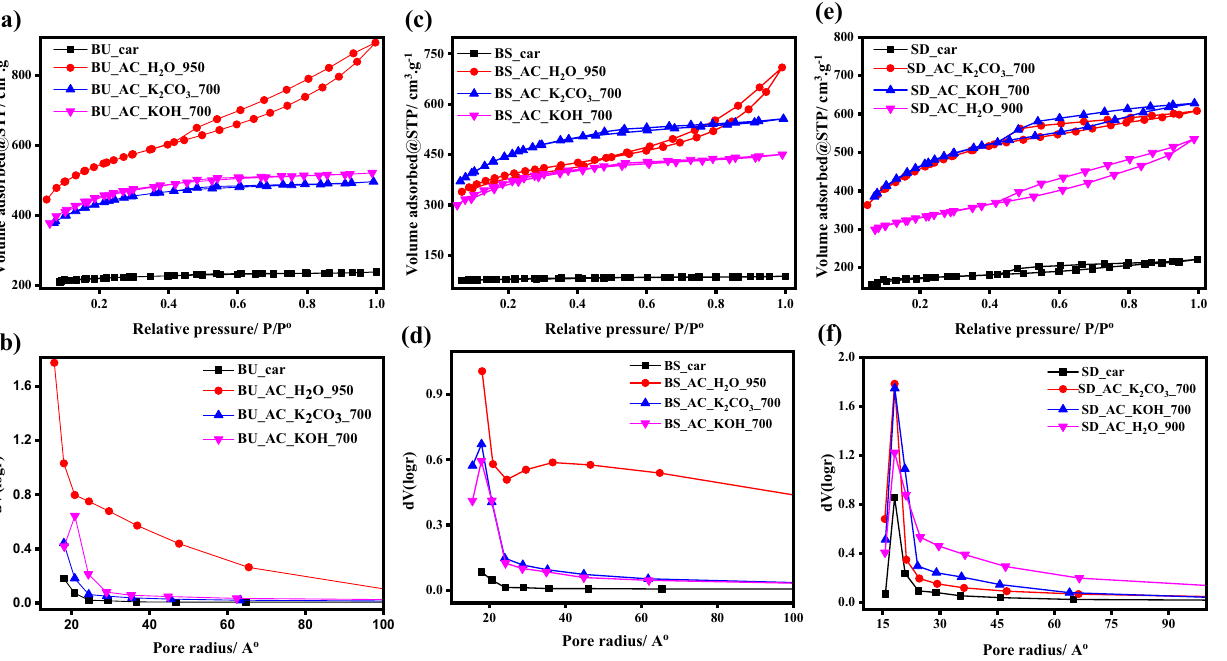
Figure 8. The N 2 adsorption–desorption isotherm and particles pore distribution of BU ( a , b ), BS ( c , d ), and SD ( e , f ) and their activated products using water vapor, K 2 CO 3 , and KOH-activators.